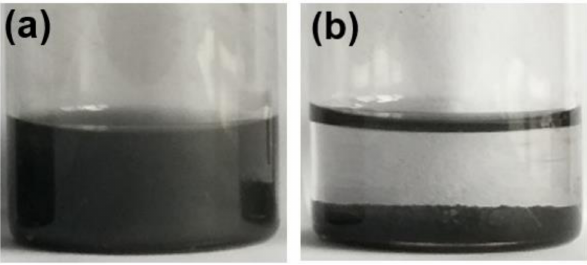
Figure 5. Optical images of 1mg/mL ( a ) PSS-G and ( b ) G dispersed in water after 48 h.